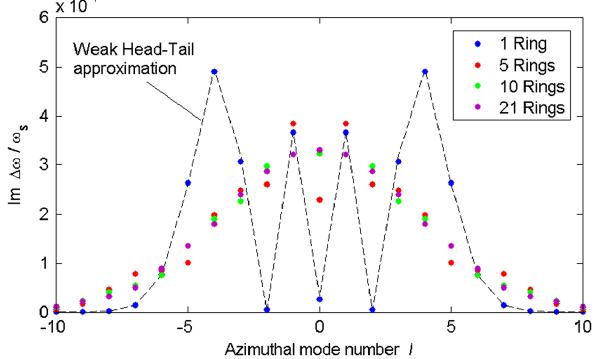
FIG. 4. For the airbag distribution, the NHT solution (blue dots) exactly matches the results of the analytical formula for weak head-tail Eq. (20) (dashed line). As we change the distribution to a Gaussian by adding more radial rings the growth rates of the individual azimuthal modes change slightly, but the overall picture remains qualitatively the same: many azimuthal modes get excited and they have similar growth rates. Equispaced beam of 3564 bunches, 10 10 ppb, ξ ¼ 0 , no damper.